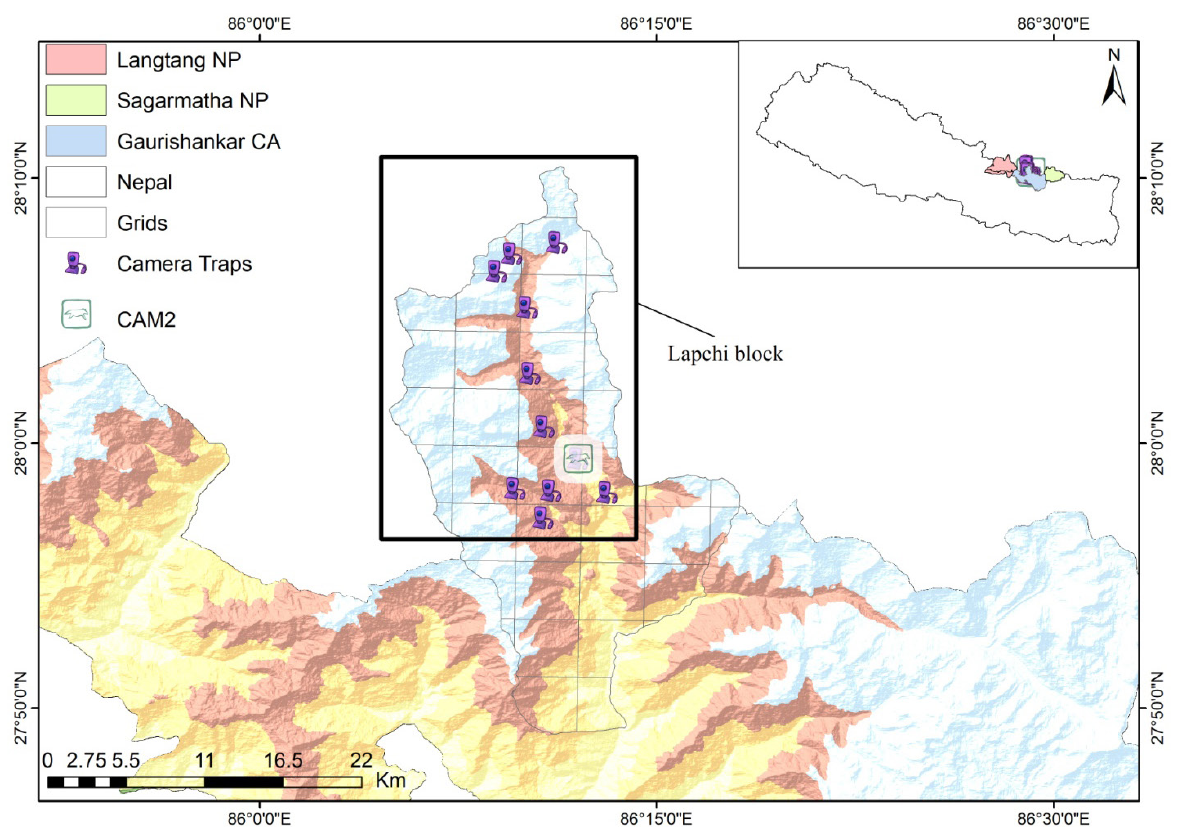
Figure 2. Study area in Lapchi block of GCA with camera trap locations, geo-processed between 2,100m and 4,100m elevation (in pink). The location where the Asiatic Golden Cat was recorded is indicated by the CAM2